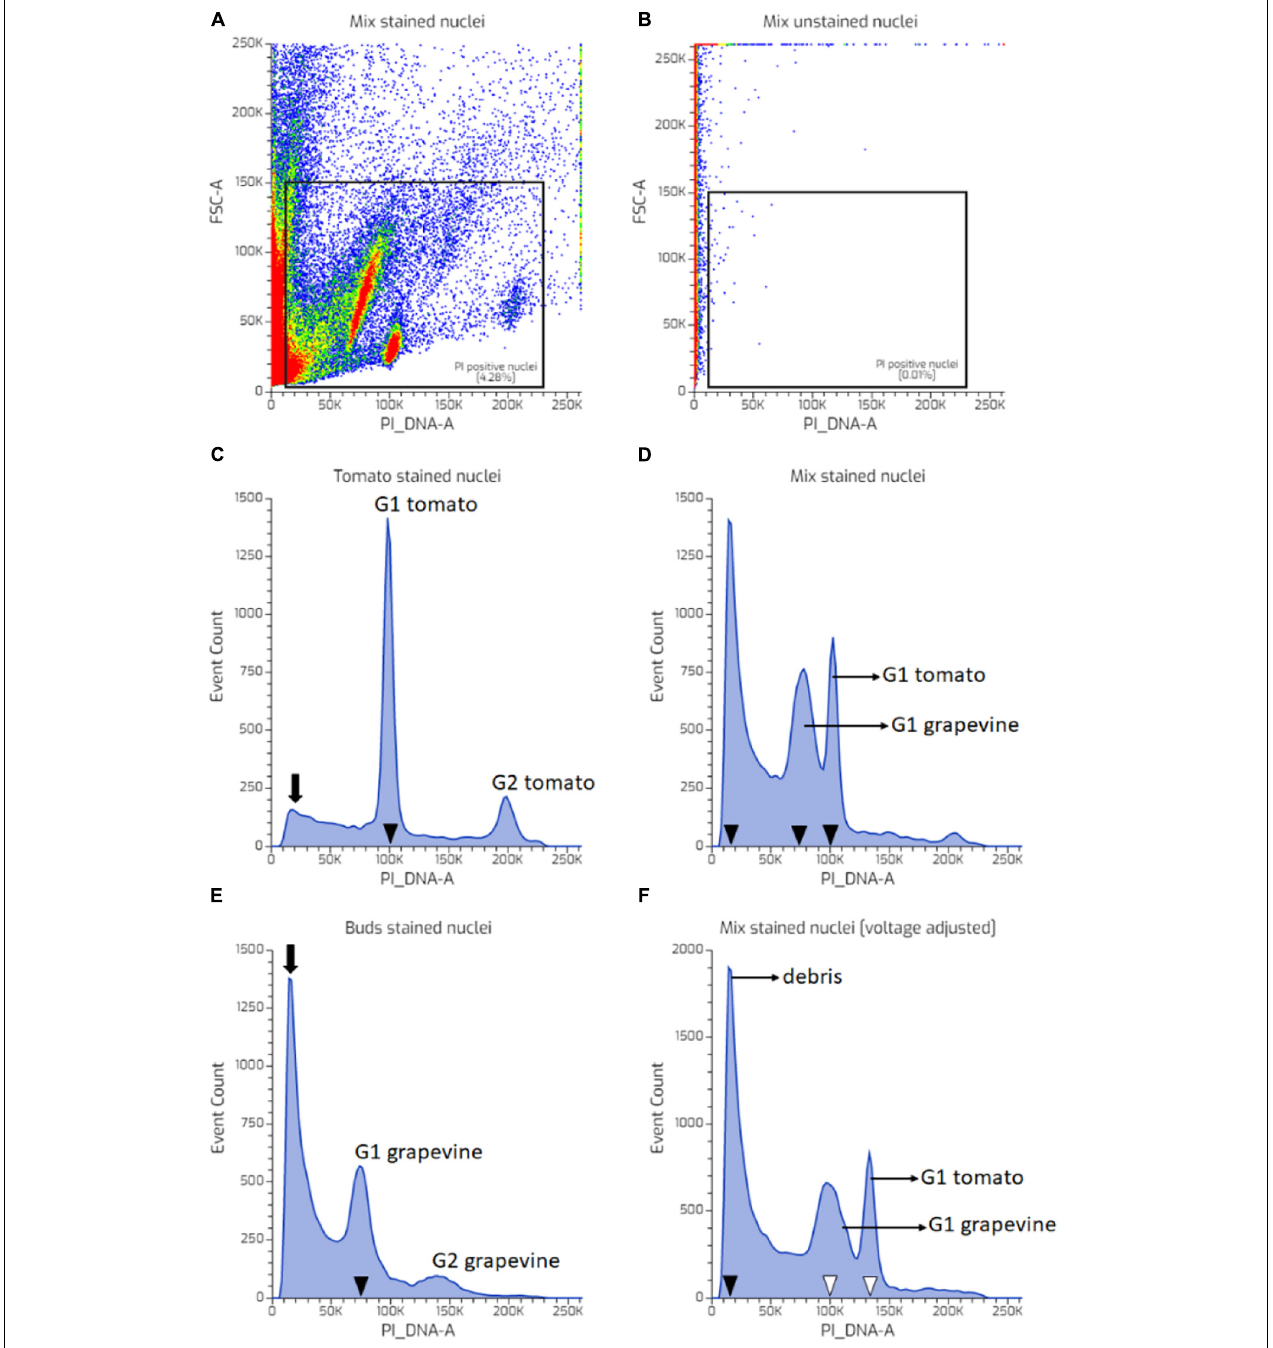
FIGURE 1 | Flow cytometry (FCM) instrument setting and identification of grapevine bud nuclei peak, using tomato nuclei as an internal standard. (A) A uniparametric distribution of propidium iodide (PI)-stained mix nuclei suspension with one of the highly abundant populations (red coloured) adjusted to be in the channel 100 K. (B) A uniparametric distribution of unstained mix nuclei suspension. (C) A uniparametric distribution of PI-stained tomato nuclei suspension analysed using the same instrument setting as (A) showing G1 peak located in the channel 100 K. (D) A uniparametric distribution of PI-stained mixed nuclei suspension sample showing three major peaks, i.e., at channel 100 K belong to tomato G1 nuclei (as shown in C ), at 75 and 20 K (full arrow heads). (E) A uniparametric distribution of PI-stained grapevine nuclei suspension analysed using the same instrument setting as (A,D) showing G1 peak located in the channel 75 K. (F) Increasing sensitivity of the PI_DNA photomultiplier tube (PMT) voltage resulted in shifting the G1 peaks of the grapevine and tomato nuclei to a higher PI_DNA fluorescence channel (empty arrow heads), while particles located at channel 20 K (the third peak shown in D ) remained at the same position (arrows) showing that these particles are debris which originating from grapevine nuclei suspension. Colors in dot plot indicate nuclei population density, being red as the highest and blue the lowest.